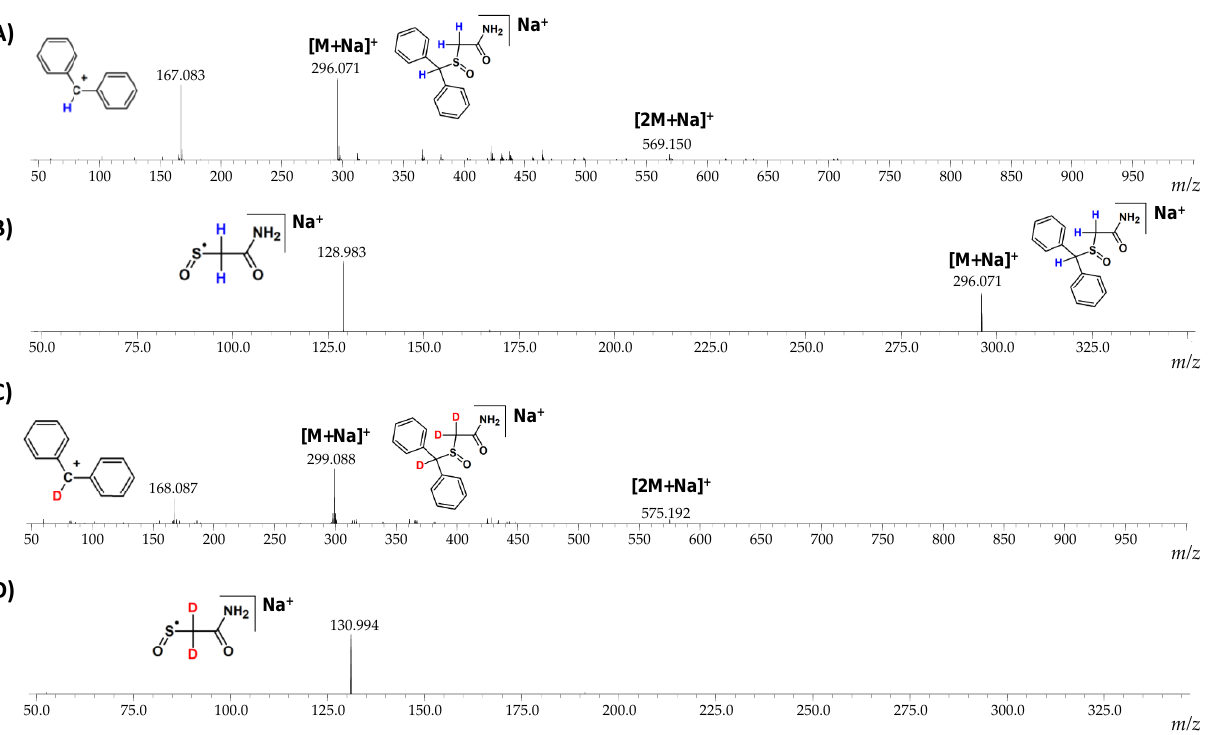
Figure 4. ( A ) ESI-MS spectrum of armodafinil, ( B ) ESI-MS/MS spectrum of armodafinil—parent ion 296.071 m / z , collision energy 30 eV, ( C ) ESI-MS spectrum of armodafinil-d 3 , ( D ) ESI-MS/MS spectrum of armodafinil-d 3 —parent ion 299.088 m / z , collision energy 30 eV.